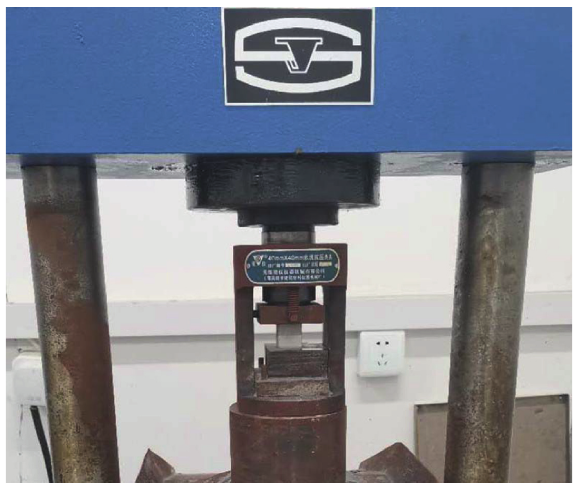
0.2750.2800.2850.2900.2950.3000.305 Weight percentage of SMK (g) Figure 4: The relation between water-to-binder ratio and the weight percentage of the